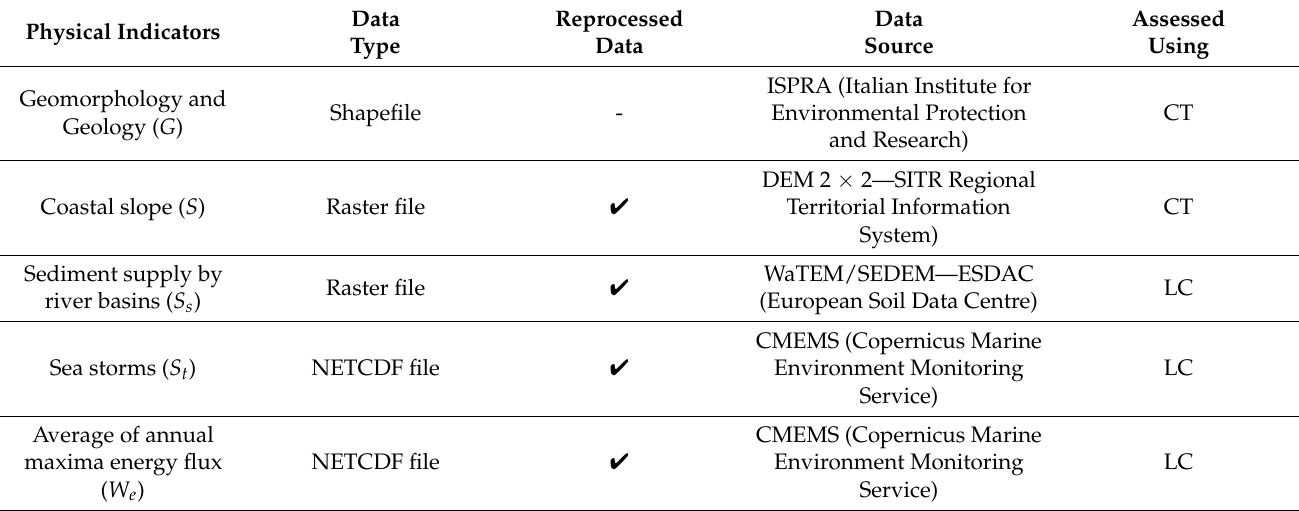
Table 1. Data sources of the parameters used in CeVI assessment. (LC—Littoral Cells, CT—Coastal